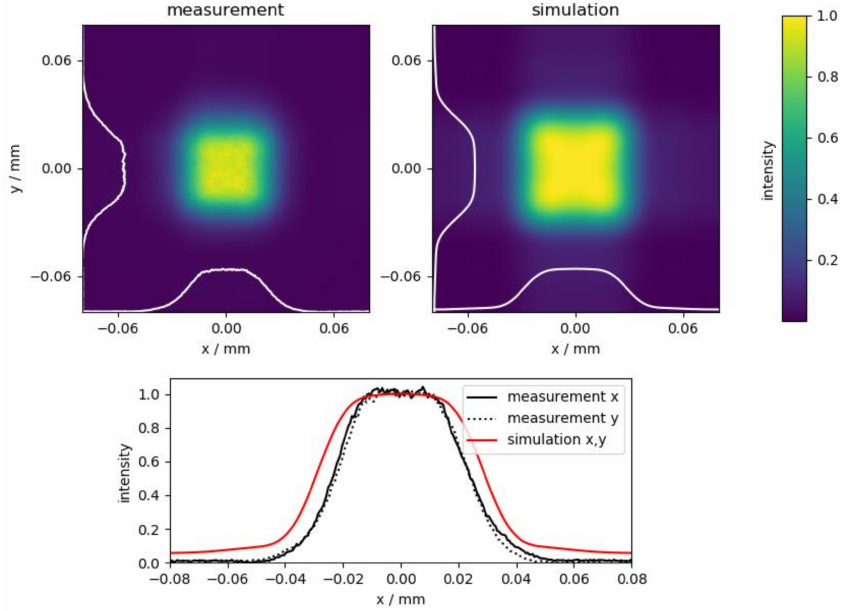
Figure 2. Color maps and cross-sections of the squared focal intensity distribution of the top-hat closest to the focal plane ( λ = 1064 nm, f = 300 mm) normalized to the maximum intensity for comparison between measurement and simulation.